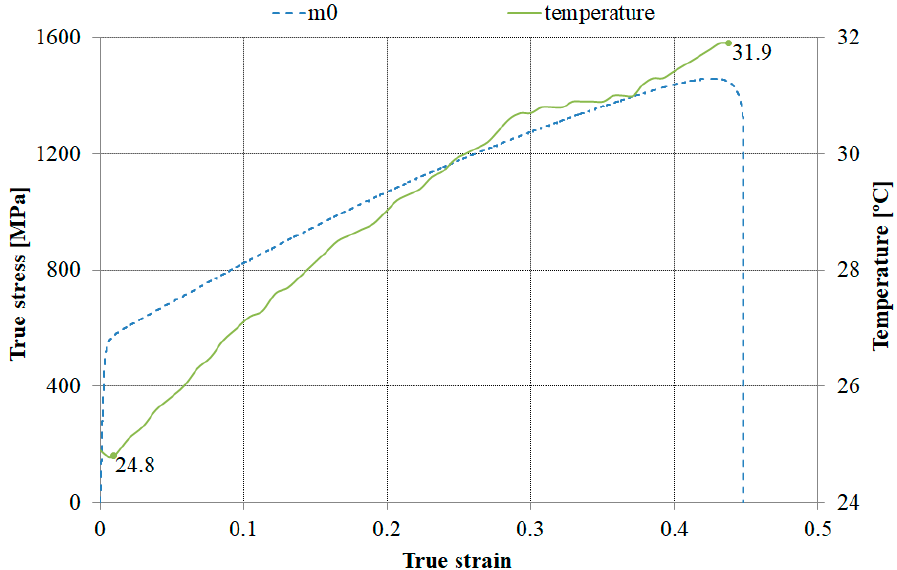
Figure 11. Temperature on the surface of a m-sample subjected to tensile loading with θ = 0° and its corresponding true stress-strain curve.